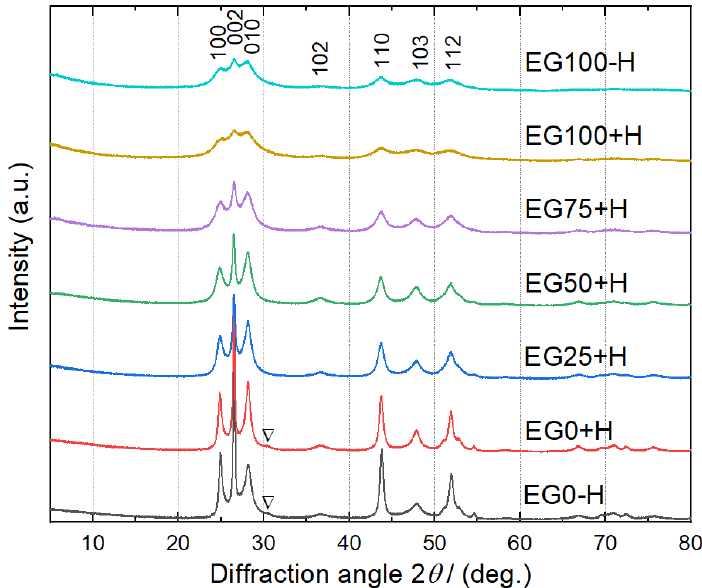
Figure 3. X-ray di ff raction (XRD) patterns of the CdS nanocomposites. Figure 3. X-ray diffraction (XRD) patterns of the CdS nanocomposites.